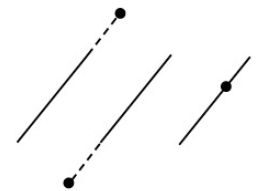
Figure 4: Positions of the point.